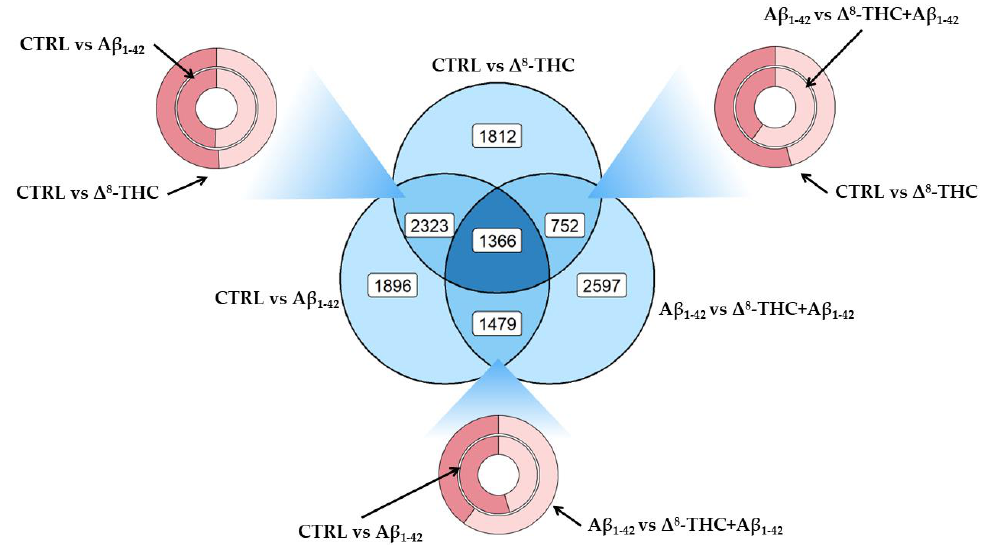
Figure 2. DEGs distribution between CTRL vs. Aβ 1-42, CTRL vs. Δ 8 -THC groups or Aβ 1-42 vs. Δ 8 -THC + Aβ 1-42 . Venn diagram in the center of the plot highlights the amount of DEGs found exclusively in each comparison (outer circles), how many DEGs found in two groups but not in the other (intersection of two circles) or how many DEGs were found in each comparison (center of the diagram). Each donut plot highlights, in turn, the intersection of two comparisons showing in dark red the upregulated and in the light red the downregulated DEGs.